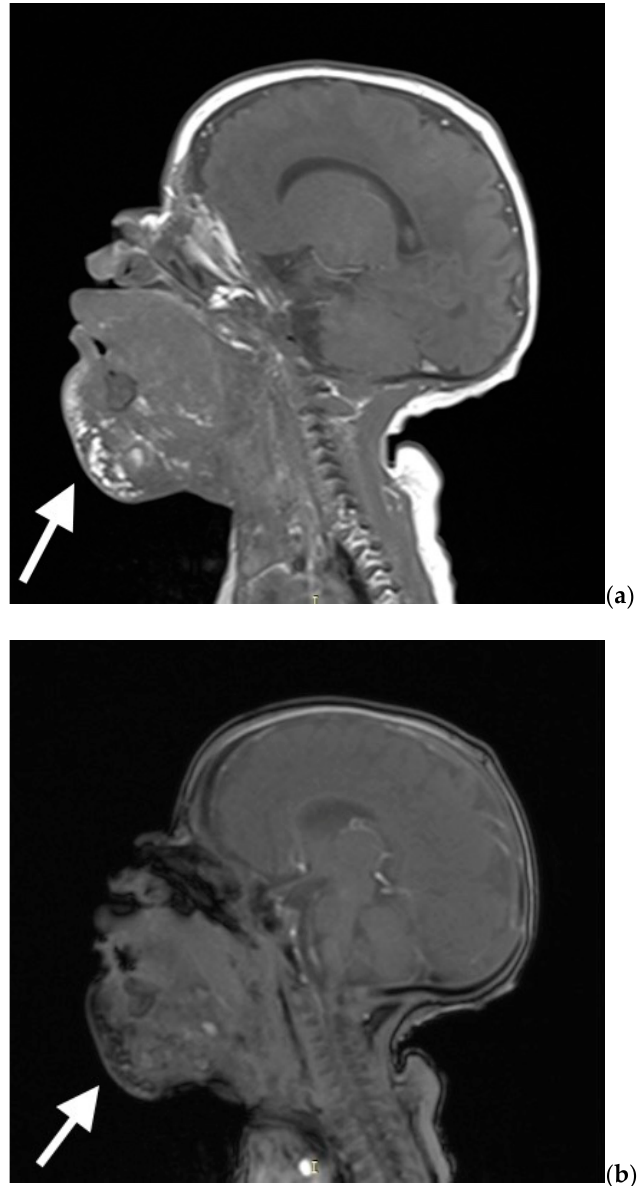
Figure 6. ( a,b ) MRI scan on 70th day of life—an extensive multicystic lesion with multiple septa penetrating both sides of the oral cavity, parotid salivary gland, and sublingual space, between the muscles of the oral cavity floor, including the whole submandibular area.